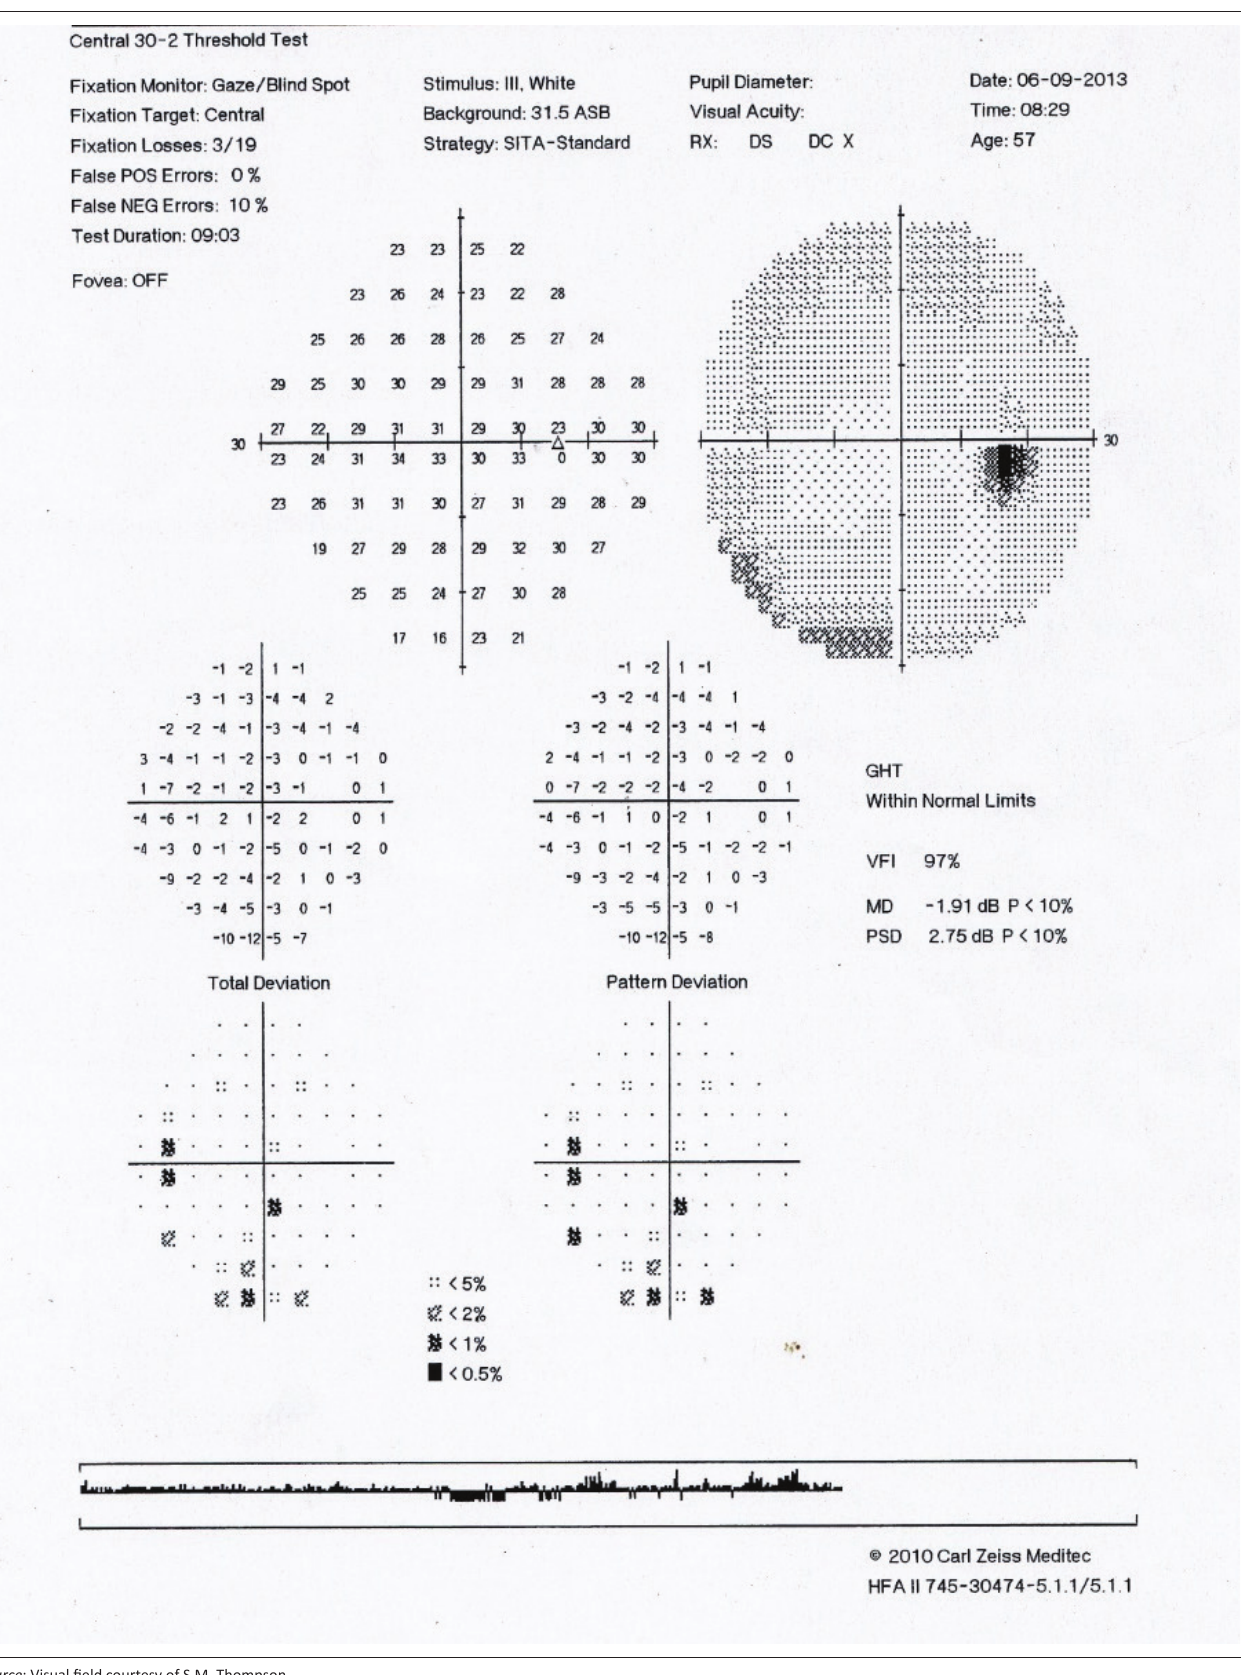
FIGURE 1: Humphrey Visual Field Test (Central 30-2 threshold) showing a normal visual field for the right eye (or